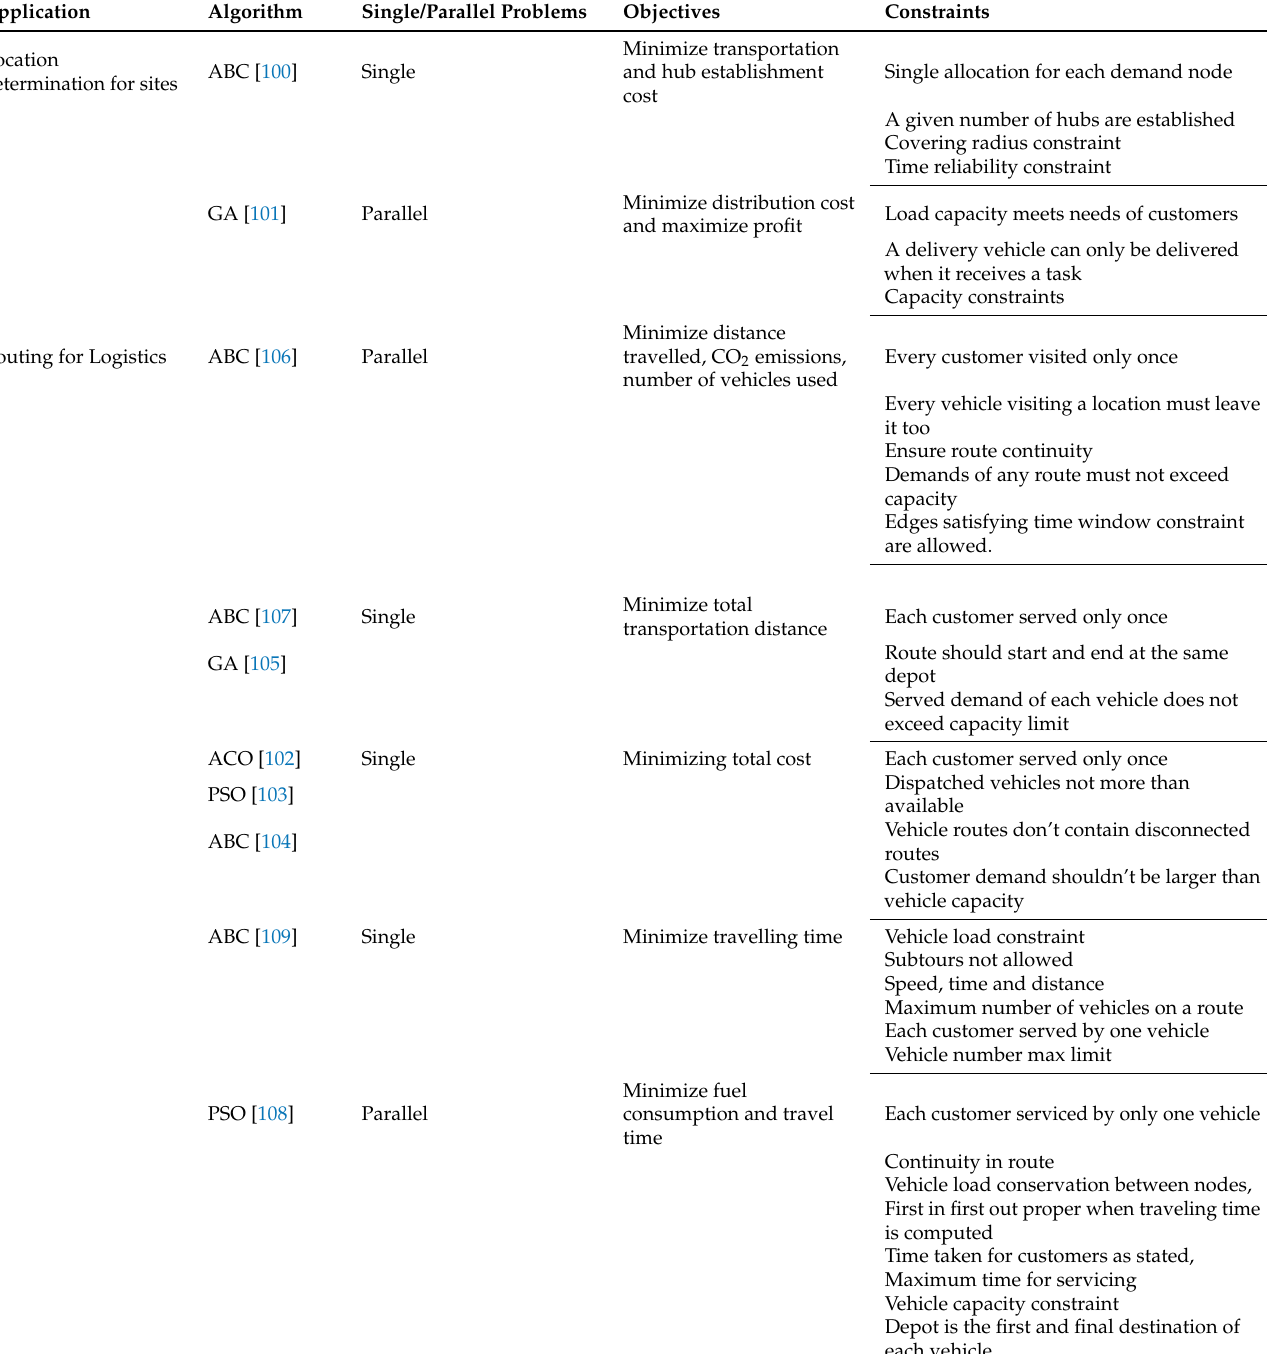
Table 11. Optimization in Smart